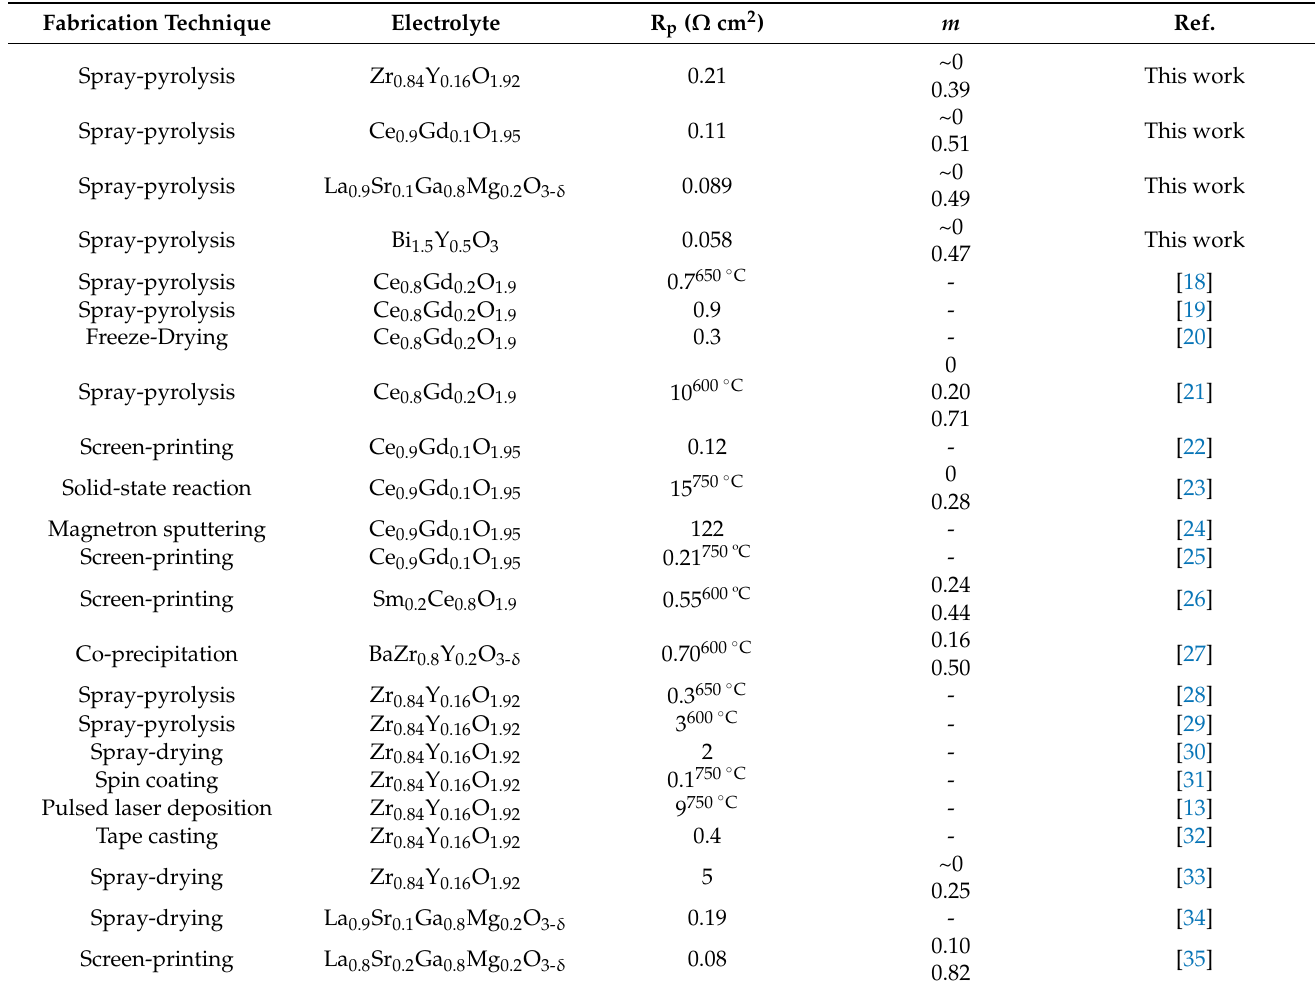
Table 1. Brief summary of the polarization resistances (R p ) and reaction order ( m ) of the